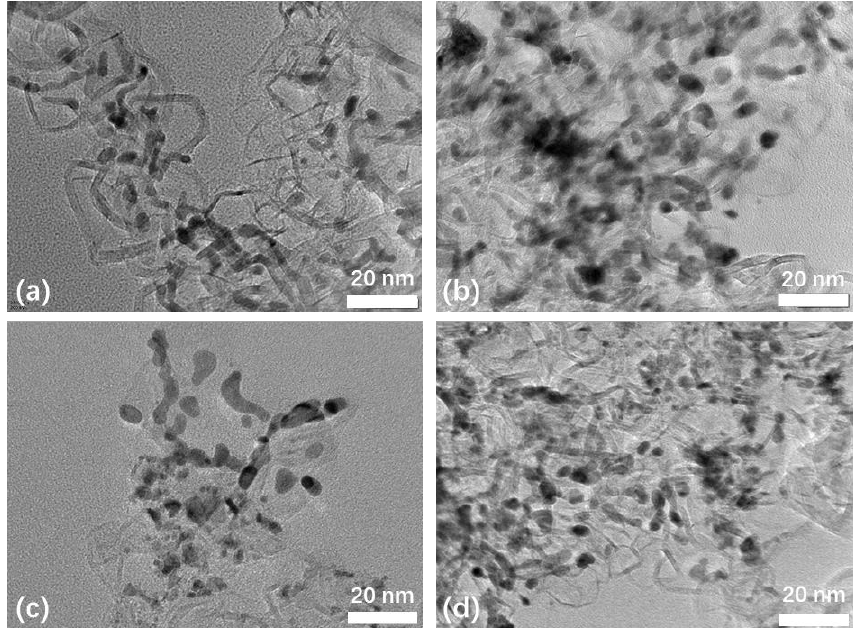
Figure 6. TEM images of fresh ACL ( a ) and aged ACL: hybrid-RTA ( b ), layered-RTA ( c ), and GDE- RTA ( d ). RTA ( d